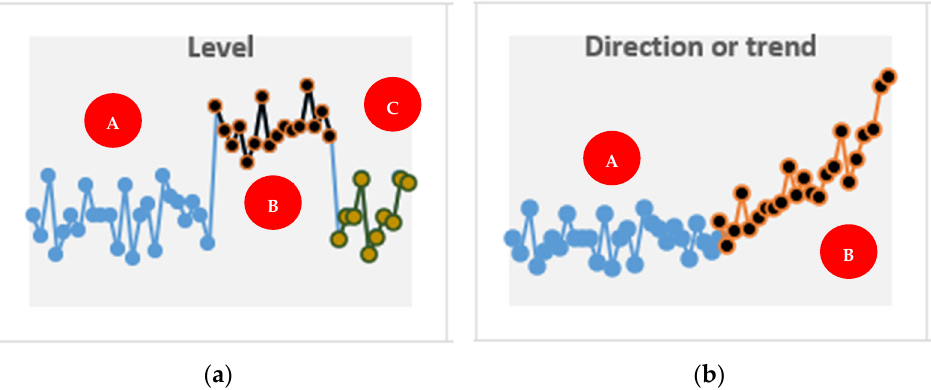
Figure 1. Examples of process regime shifts in ( a ) level and ( b ) trend of the output event log time series data.